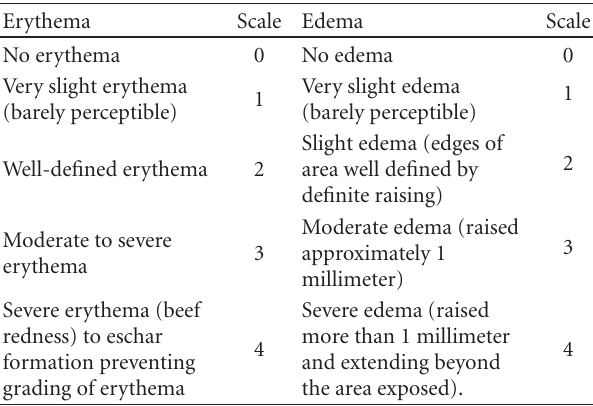
Table 1: United States Testing Company (USTC) erythematic and edema evaluation scale